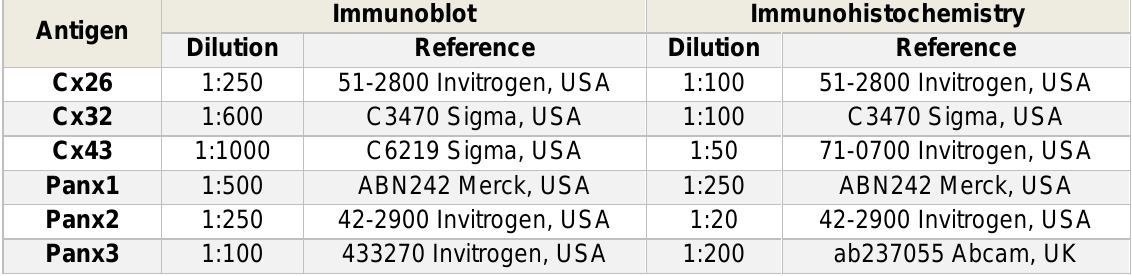
Table 3: Primary antibodies used in immunoblotting and immunohistochemistry analysis. Dilu- tion and reference of each antibody are